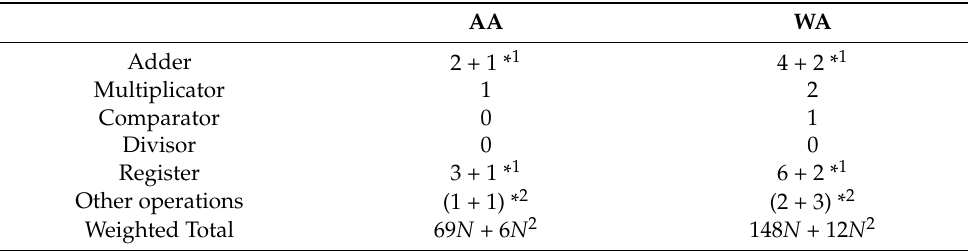
Table 3. Detection performances of post-norm algorithm at different firing rates at SNR = 0 dB Table 5. Resources required by the hardware implementation of noise estimate blocks. The length M (C = 50). of the window is assumed to be a power of 2, to avoid hardware